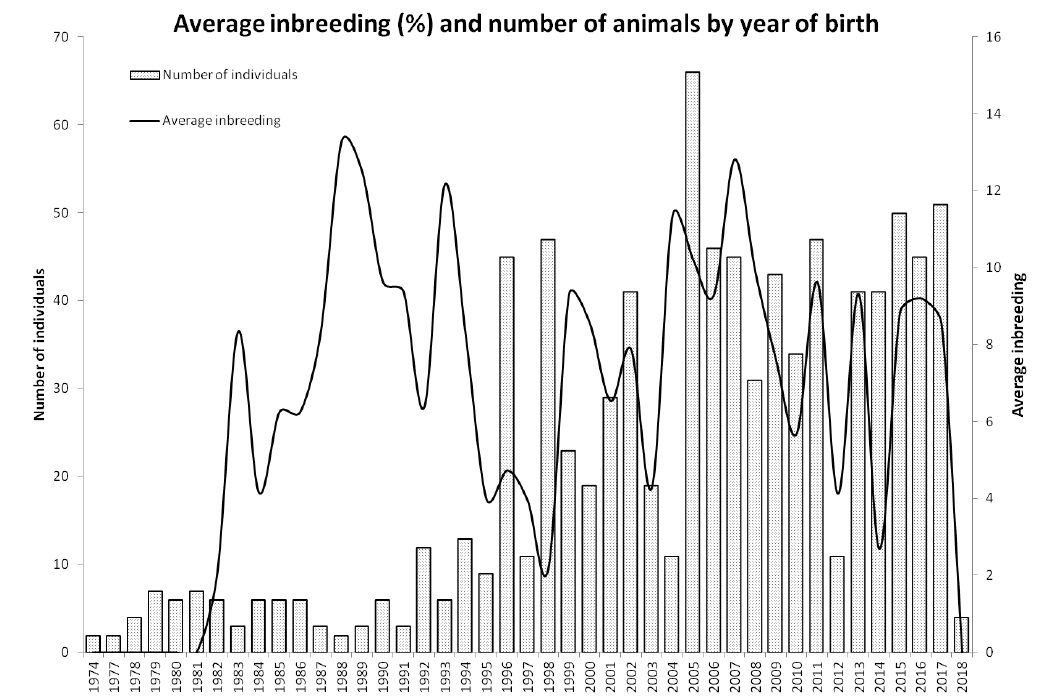
Figure 4. Average inbreeding (%) and number of animals by year of birth. Table 2. Polymorphism of 21 microsatellite DNA markers in the Polish Greyhound (n = 174). Locus